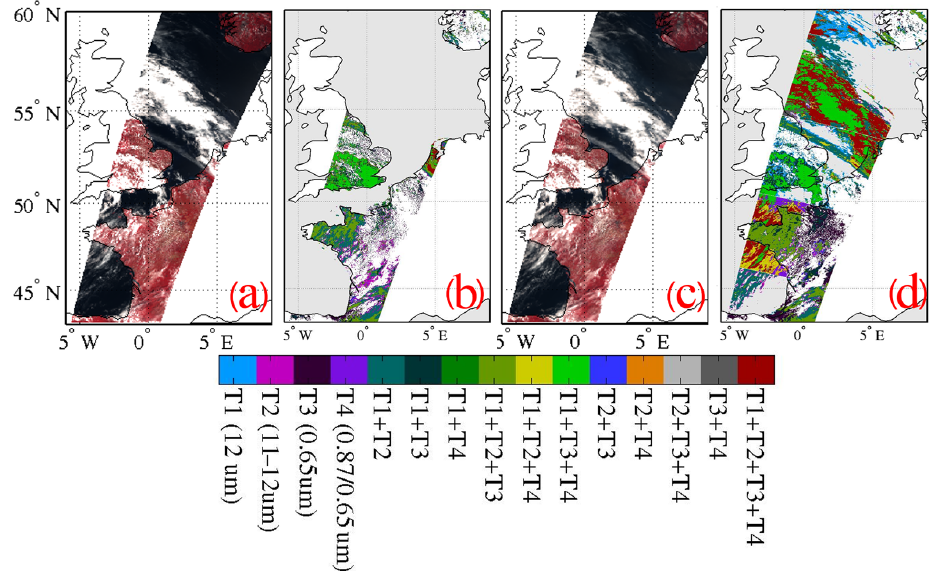
Figure 1. False-colour RGB images (composite of 0.555, 0.659 and 0.865µm) from the AATSR nadir (a) and forward (c) views over part of western Europe on 29 July 2008, 10:00UTC. Along the track, vegetation over land is coloured in red, ocean is coloured in black, and clouds are coloured in white. Dark areas are cloud free. Cloud-screening test T1–T4 results are presented for nadir (b) and forward (d) views with colours indicating the (combination of) tests (colour bar at the bottom). See Sects. 2.2 and 3 for further explanation.